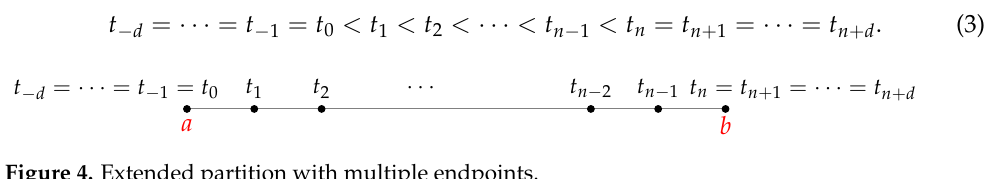
Figure 4. Extended partition with multiple